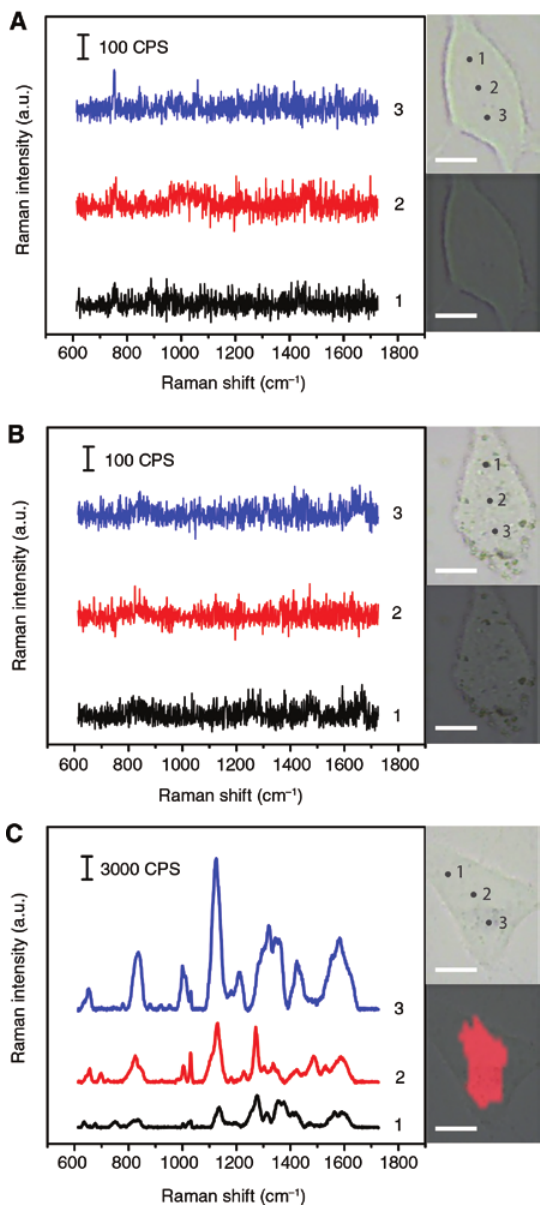
Figure 2: Raman mapping and corresponding spectra of HepG2 cells incubated with (A) fresh medium, (B) BP NSs and (C) BP-Au NSs. Scale bar: 15 μ